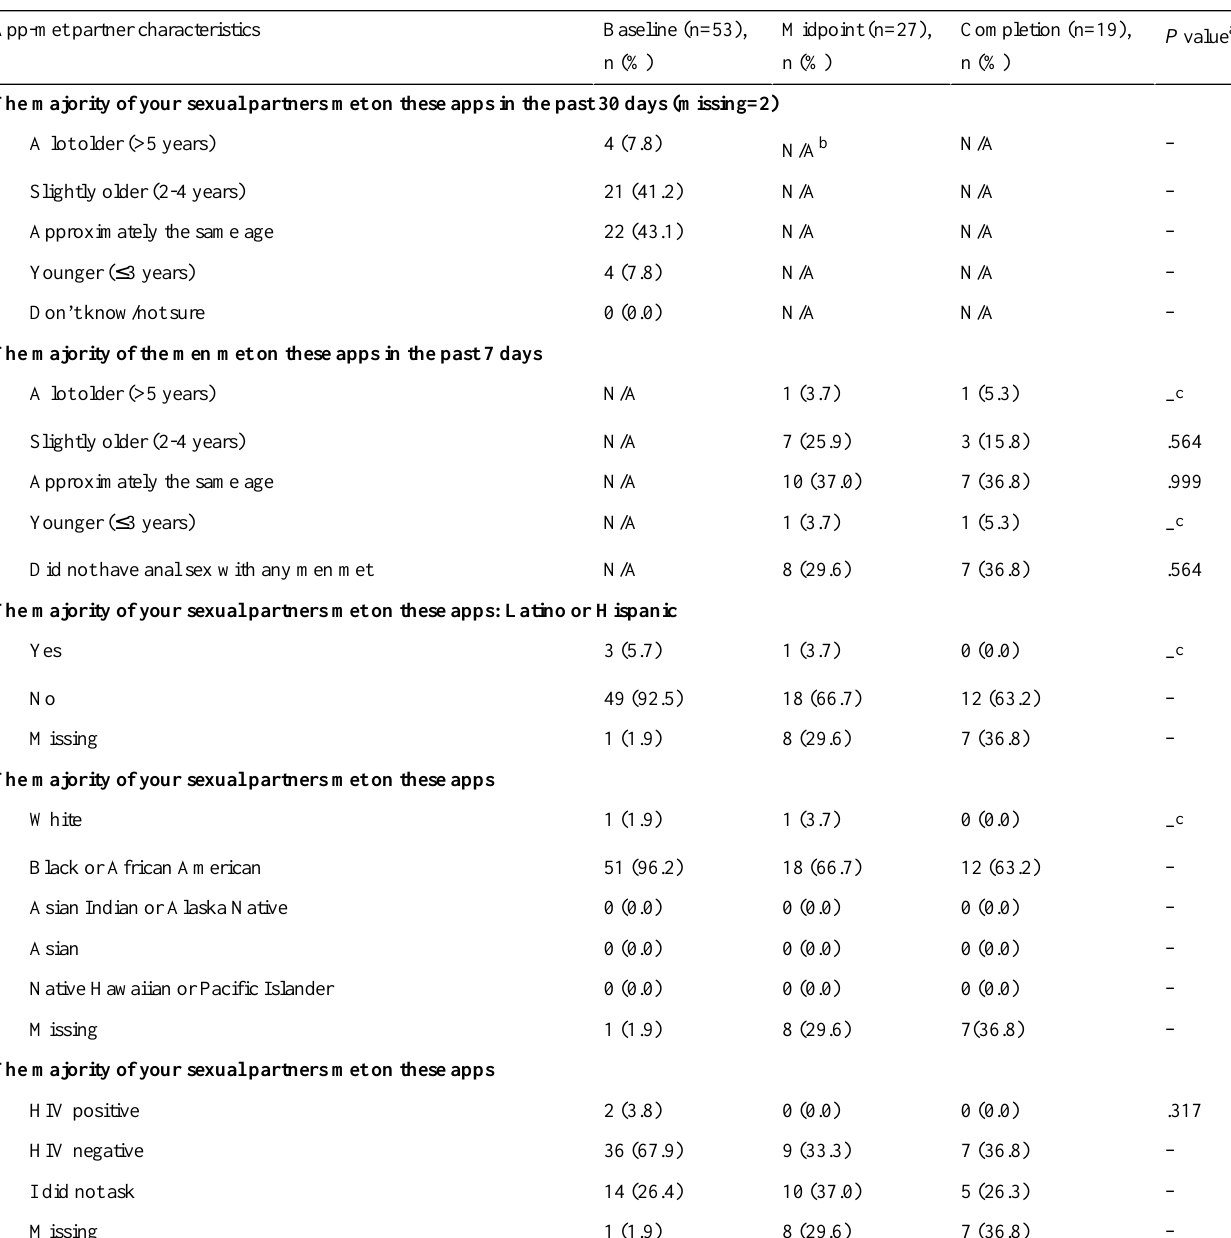
Table 5. App-met partner characteristics across three time periods among app-using men who have sex with men.